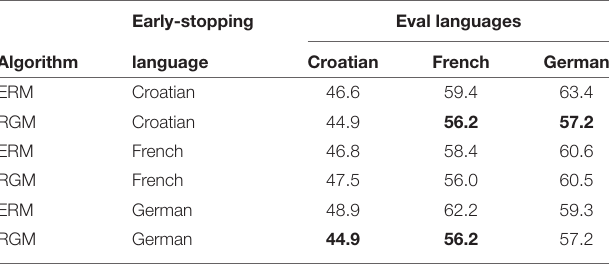
TABLE 5 | Phone token classification error rates (PTCER, %) of an ASR trained on three Slavic languages (Czech, Bulgarian and Polish) and tested on one Slavic language (Croatian) and two other Indo-European languages (French and German).